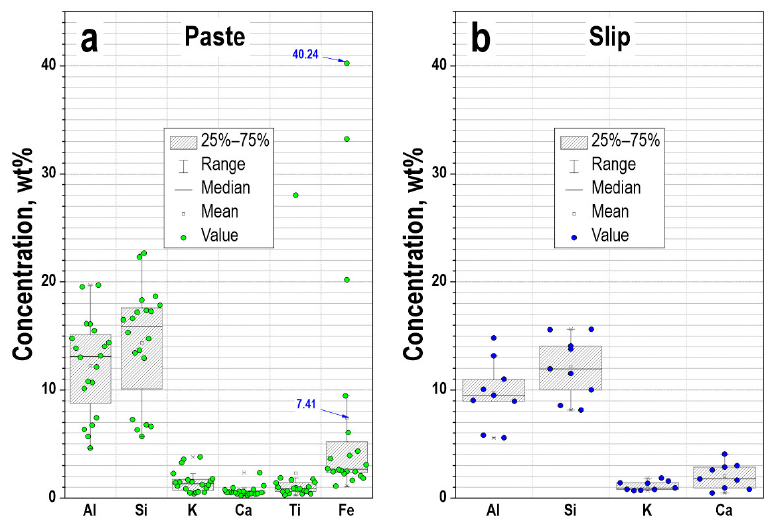
Figure 6. Box-and-whiskers plots for chemical compositions of paste ( a ) and slip ( b ).